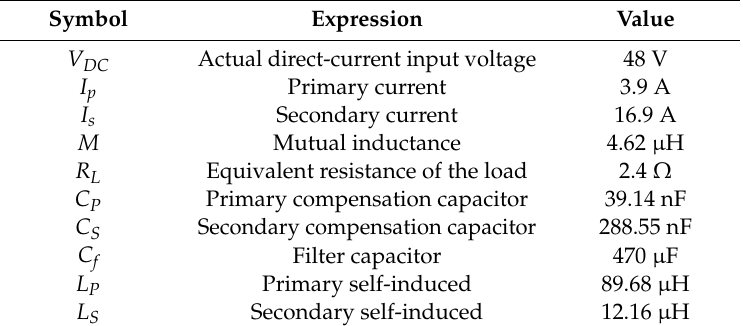
Table 5. Symbol explanation in Figure 9.